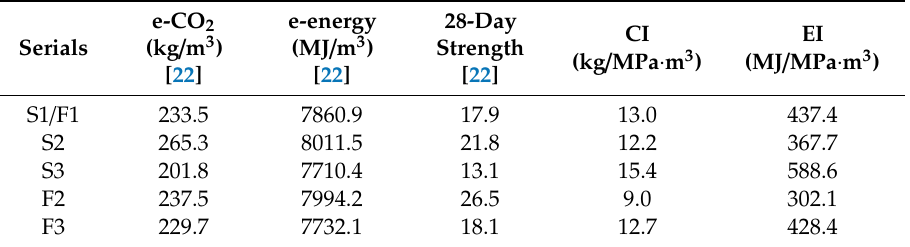
Table 6. Greenness indices of